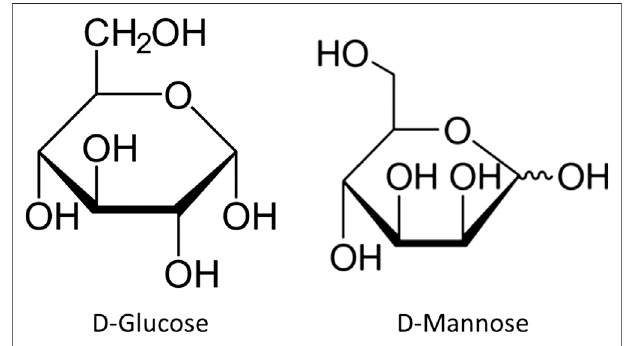
FIGURE 1 | Chemical structure of D-glucose and